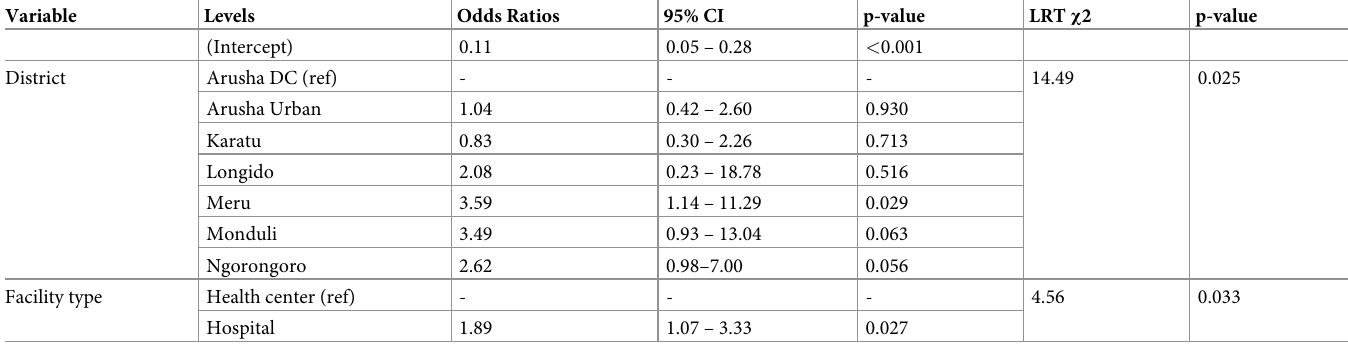
Table 3. Multivariable model of variables associated with proportion of individuals testing positive for brucellosis at health facilities in Arusha region (n = 776 monthly observations from 20 facilities). Variable